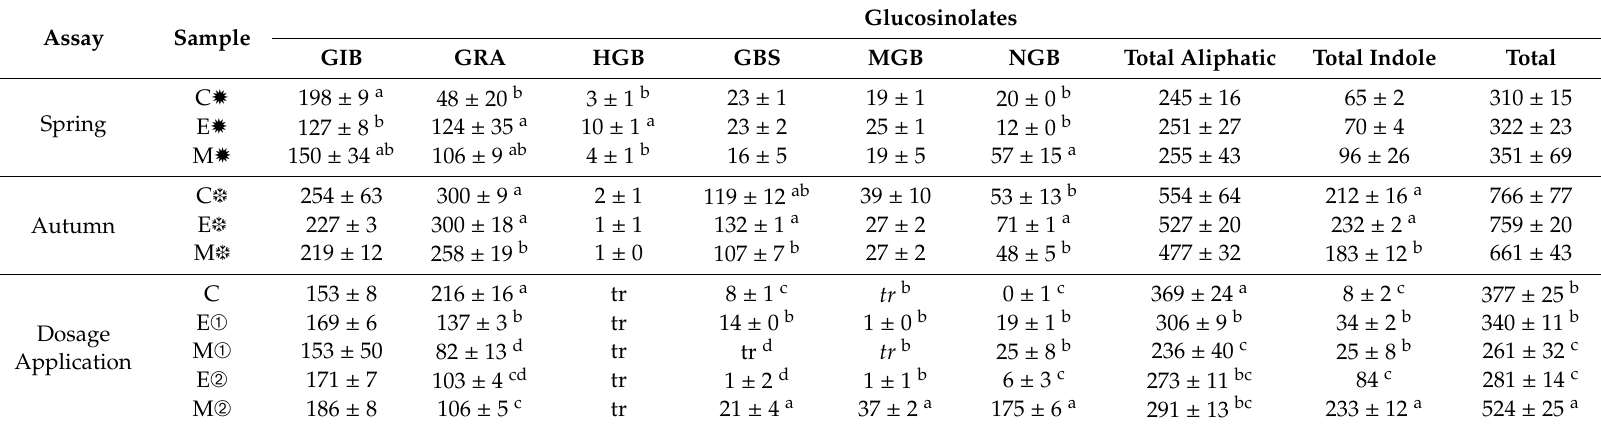
Table 4. Content of glucosinolates (mg / kg f.w.) in broccoli florets analyzed by HPLC-DAD for both seasonal assays (spring and autumn) and the dosage application assay. Glucosinolates are presented as individual compounds (GIB: glucoiberin (3-Methylsulfinylpropyl-gls), GRA: glucoraphanin (4-Methylsulphinylbutyl-gls), HGB:hydroxyglucobrassicin(4-Hydroxy-3-indolylmethyl-gls),GBS:glucobrassicin(3-Indolylmethyl-gls),MGB:4-Methoxyglucobrassicin(4-Methoxy-3-indolylmethyl-gls), NGB: neoglucobrassicin (1-Methoxy-3-indolylmethyl-gls)), grouped as aliphatic and indole glucosinolates, and as total glucosinolates, calculated as the sum of the different individual